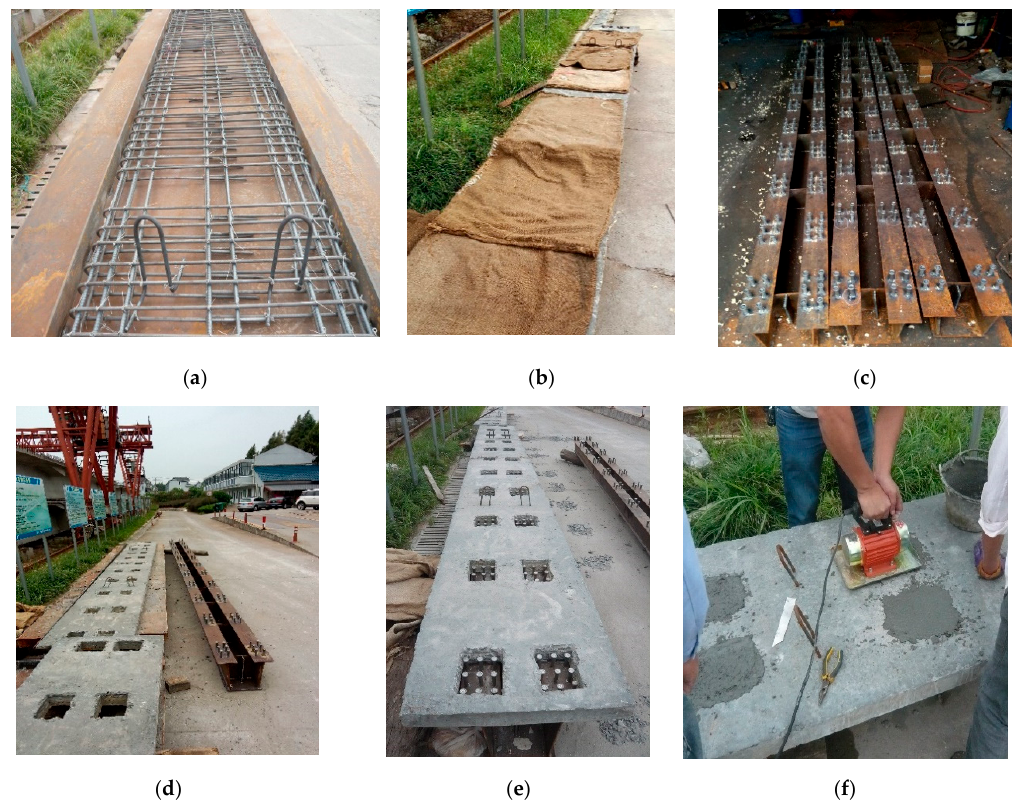
Figure 2. Fabrication process of the experimental beams: ( a ) formwork erection and reinforcing case binding; ( b ) casting and curing of concrete slab; ( c ) stud welding of test specimens; ( d ) completion of the concrete slab and steel U-type girder; ( e ) placing of concrete slab on steel box girder to make it composite; ( f ) reserve hole filling.